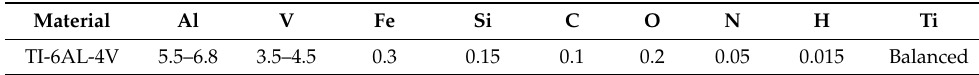
Table 1. The composition of TI ‐ 6AL ‐ 4V (wt.%).